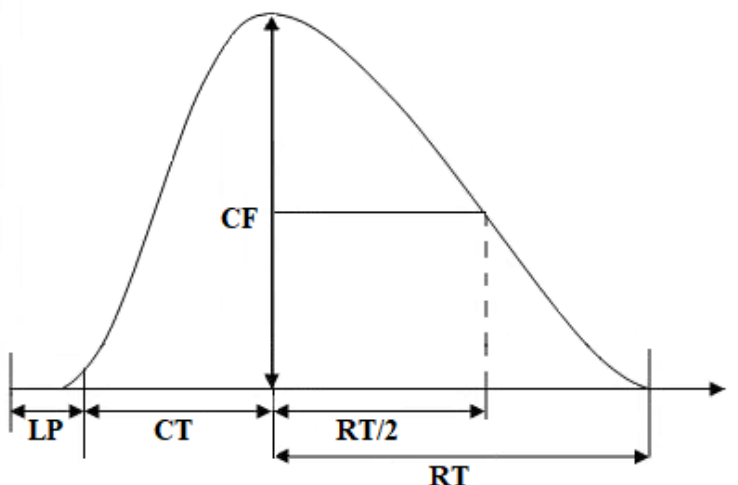
Figure 7. Schematic diagram of recording contractile parameters. CF — contraction force, LP — latency period, CT — contraction time, RT — relaxation time, RT/2 — half-relaxation time.